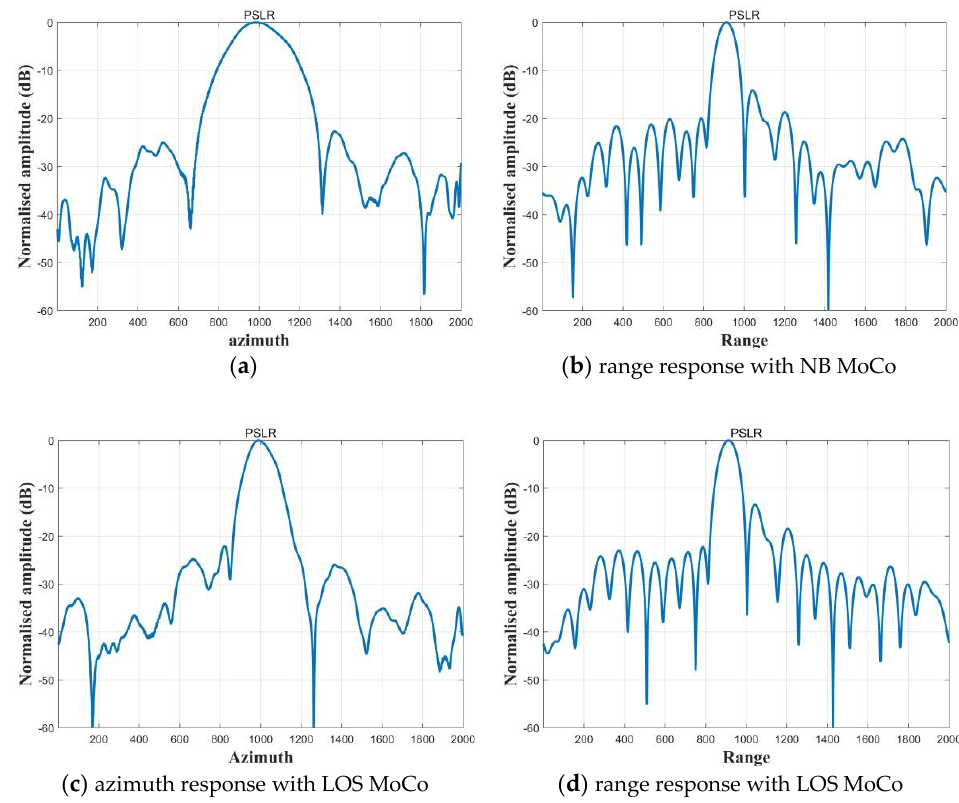
Figure 10. Corner reflector profiles of CR#1 with different MoCo methods. (a) Azimuth response with NB MoCo. (b) Range response with NB MoCo. (c) Azimuth response with LOS MoCo. (d) Range response with LOS MoCo. Table 4. Evaluation of corner reflectors of CR#1.